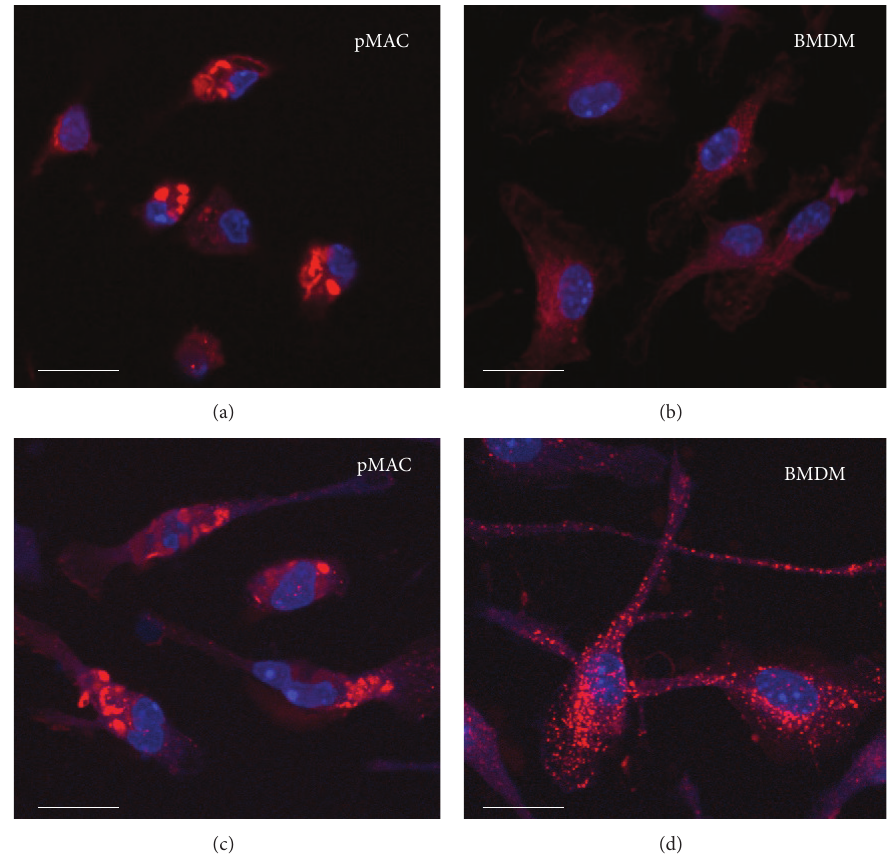
Figure 2: pMACs and BMDMs have distinct lysosome morphology. (a–d) pMACs (a, c) or BMDMs (b, d) were incubated with lysotracker red (a, b) or TMR-dextran (c-d) to label lysosomes. Nuclei are stained with Hoechst (blue). Representative immunofluorescent images are shown. The white bar indicates 10